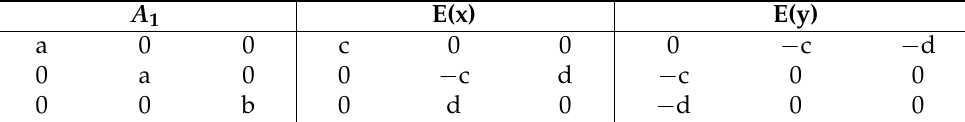
Table 1. Raman tensors for the D 3 (32) point